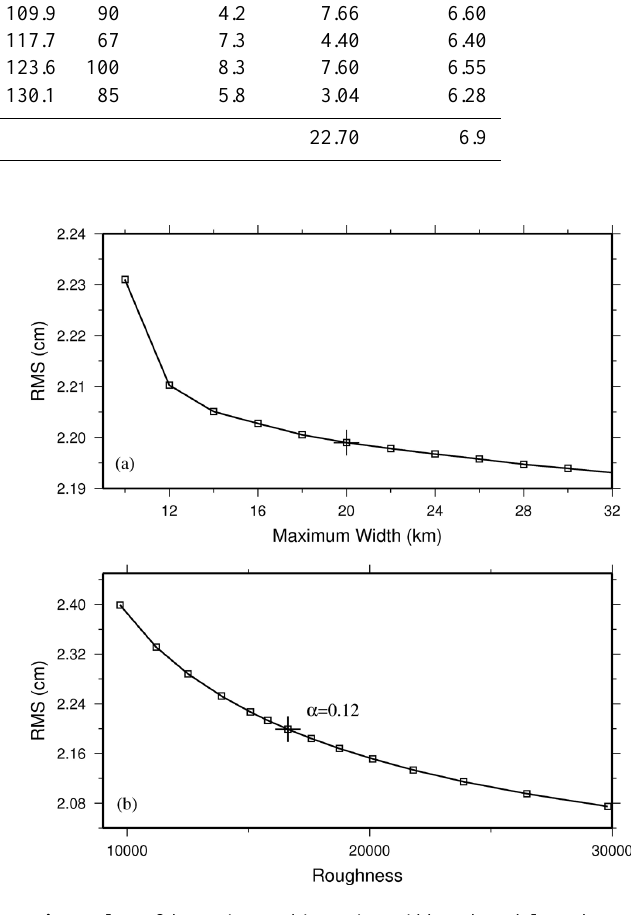
Fig. 5. Plots of data misfit and inversion width and model roughness for a range of smoothing factor. (a) Trade-off curve between the data misfit and the maximum slip width. (b) Trade-off curve between the misfit and model roughness with a width extent of 20km. The roughness is the normalized value. The pluses represent the values chosen for the inversions presented in Fig. 6. Table 3. Layered crustal structure parameters of Yushu fault